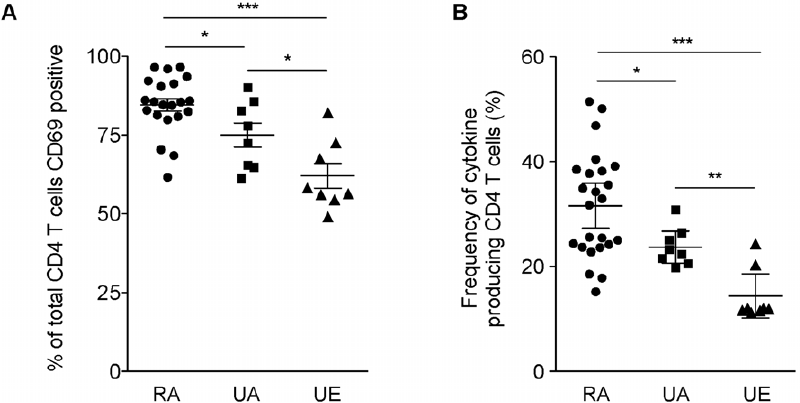
Figure 2. The magnitude of CD4 T cell cytokine response is higher in the rural population. CD4 T cell cytokine responses from adults living in rural Kenya (RA, n=25) were analysed and compared to those from urban populations of African (UA, n=8) and European (UE, n=8) donors. The functional signatures of CD4 T cells were determined after non-specific in vitro stimulation with PdBU and ionomycin via the analysis of an array of functions including IFN c , IL-2, IL-10, IL-17, TNF a , IL-21, IL-22, IL-4 and IL-9 secretion (panels 1-3 Table S1). (A) The total frequency of CD69 positive CD4 T cells following stimulation was expressed as a percentage of total CD4 T cells. (B) The total frequency of CD4 T cells expressing at least one cytokine was expressed as a percentage of CD4 T cells (%). Horizontal bars indicate the mean (95% confidence intervals are represented) for each group. Nonparametric Mann-Whitney U test was used to analyse differences in the T cell responses between groups. Statistically significant P -values ( , 0.05) are indicated by an asterisk (P , 0.05 *; P # 0.01 **; P # 0.001